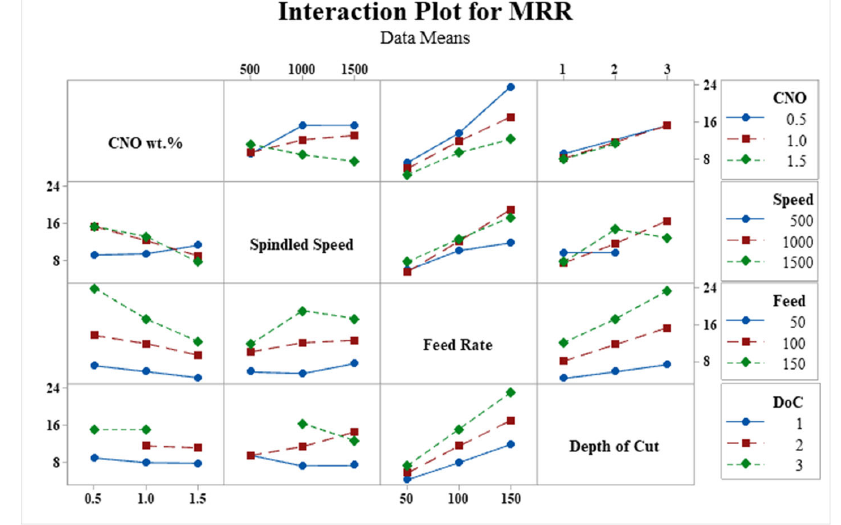
Fig. 8. Interaction Plot for